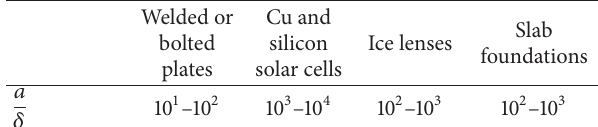
Table 2: Range of film length ratio in contact problems